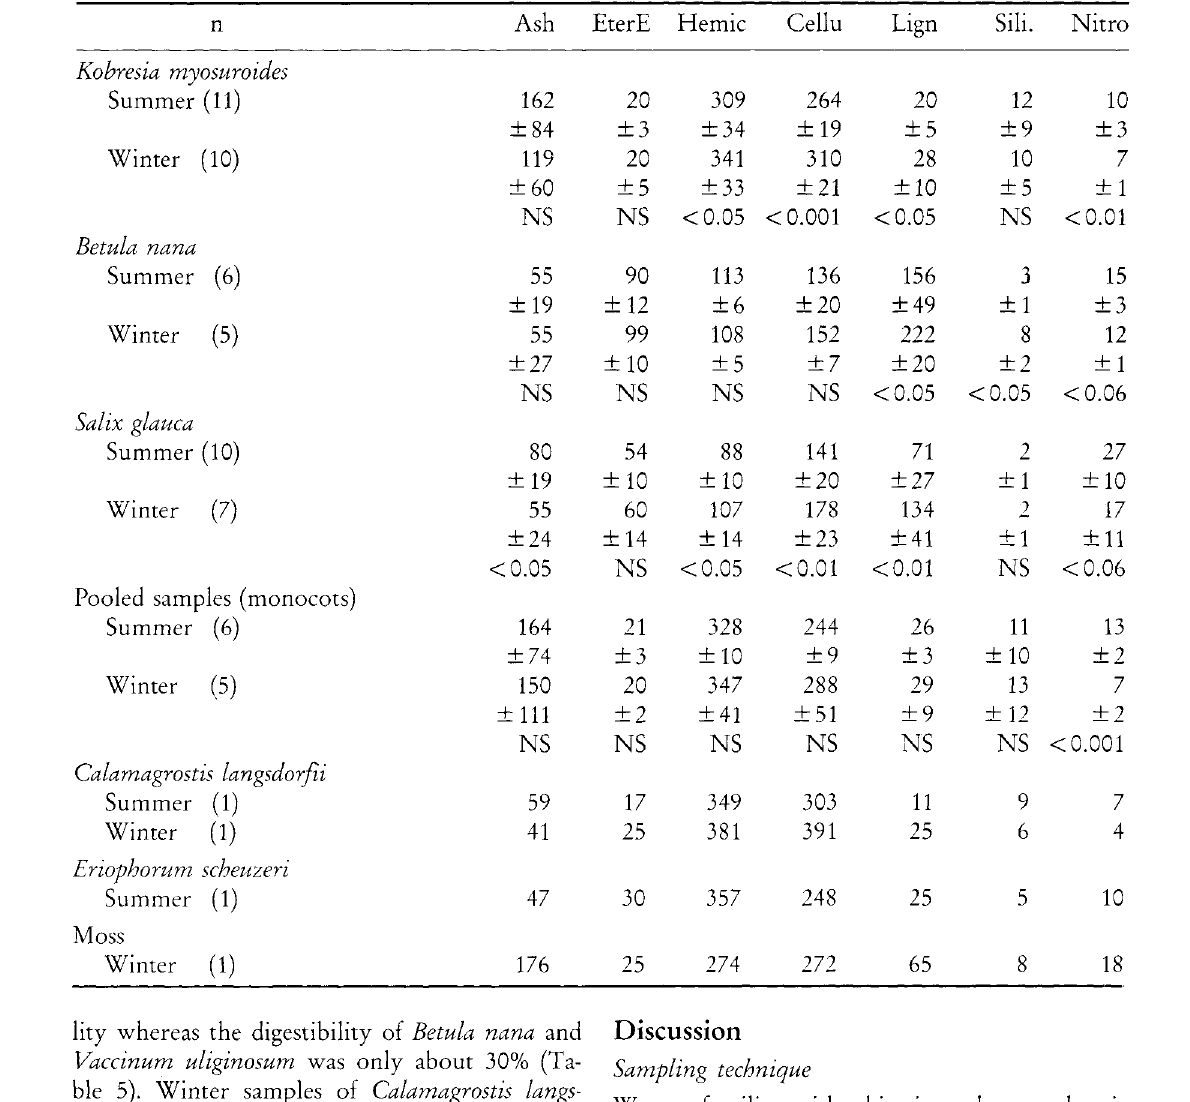
Table 4. Chemical composition of important food plants from West Greenland, (g/kg dry matter ± S.D.). n Ash